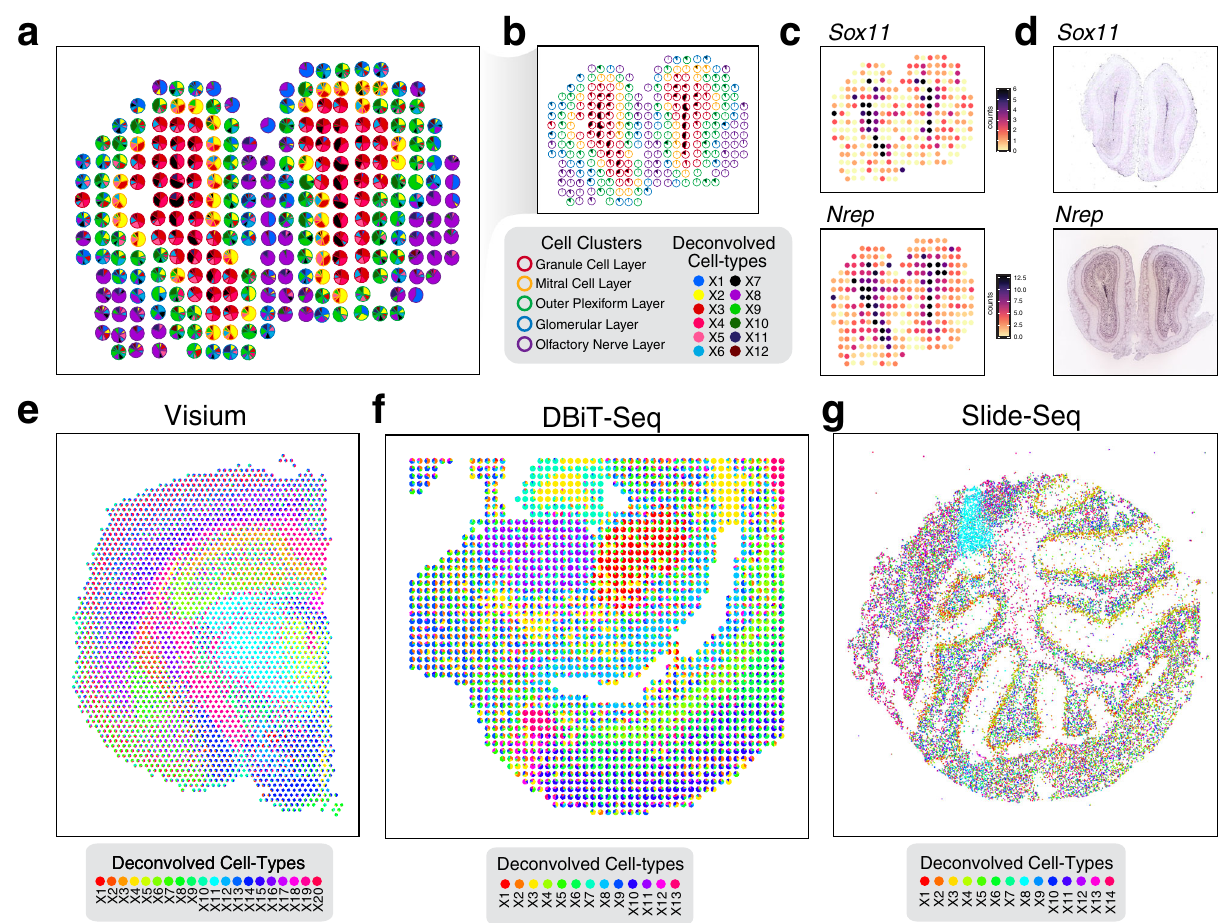
Fig. 4 Deconvolution of ST data of varying resolution from multiple technologies by STdeconvolve. a Deconvolved cell-type proportions for ST data of the MOB, represented as pie charts for each ST pixel. Pixels are outlined with colors based on the pixel transcriptional cluster assignment corresponding to MOB coarse cell layers. b Highlight of deconvolved cell-type X7. Pixel proportion of deconvolved cell-type X7 are indicated as black slices in pie charts. Pixels are outlined with colors as in ( a ). c Gene counts in each pixel of the MOB ST dataset for deconvolved cell-type X7 ’ s select top marker genes Sox11 and Nrep . d Corresponding ISH images for Sox11 and Nrep from the Allen Brain Atlas 19 . e Deconvolved cell-type proportions for Visium data of the mouse brain. f Deconvolved cell-type proportions for DBiT-seq data of the lower body of an E11 mouse embryo. g Deconvolved cell-type proportions for Slide-seq data of the mouse